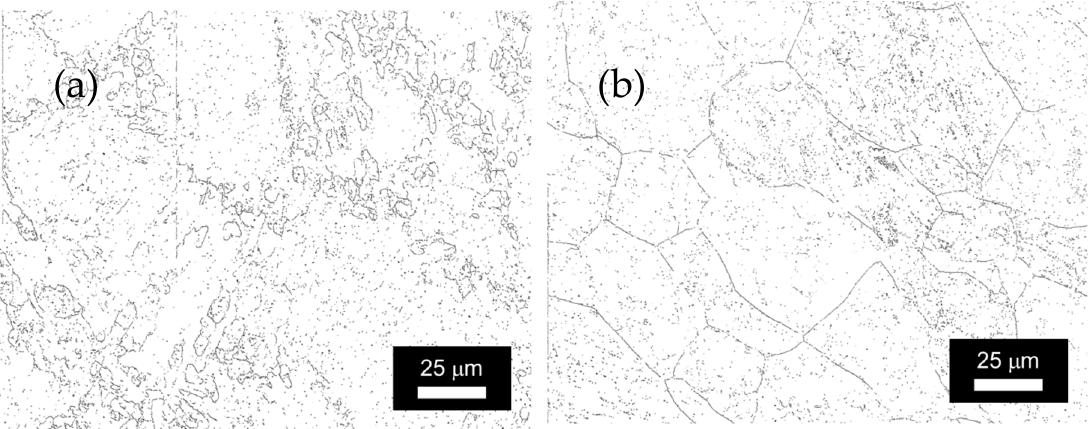
Figure 6. Misorientation boundary angles of 15–45° shown for the ( a ) N L Q L and ( b ) N L Q H conditions.